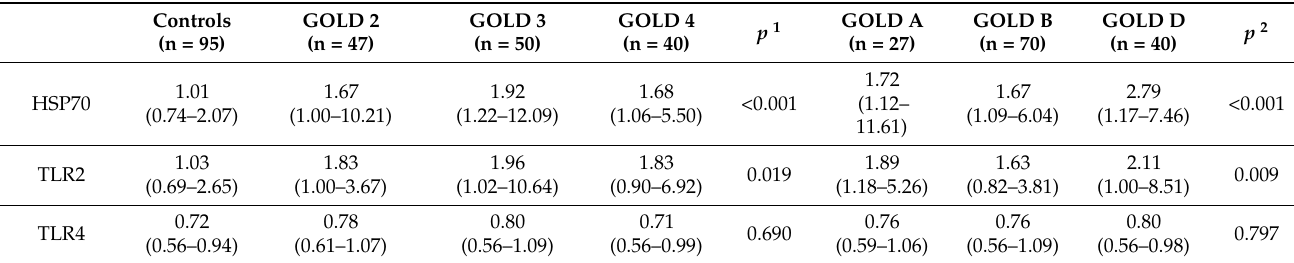
Table 4. Relative expression of HSP70 , TLR2 and TLR4 in controls and COPD patients according to the severity of airflow obstruction and symptoms severity.